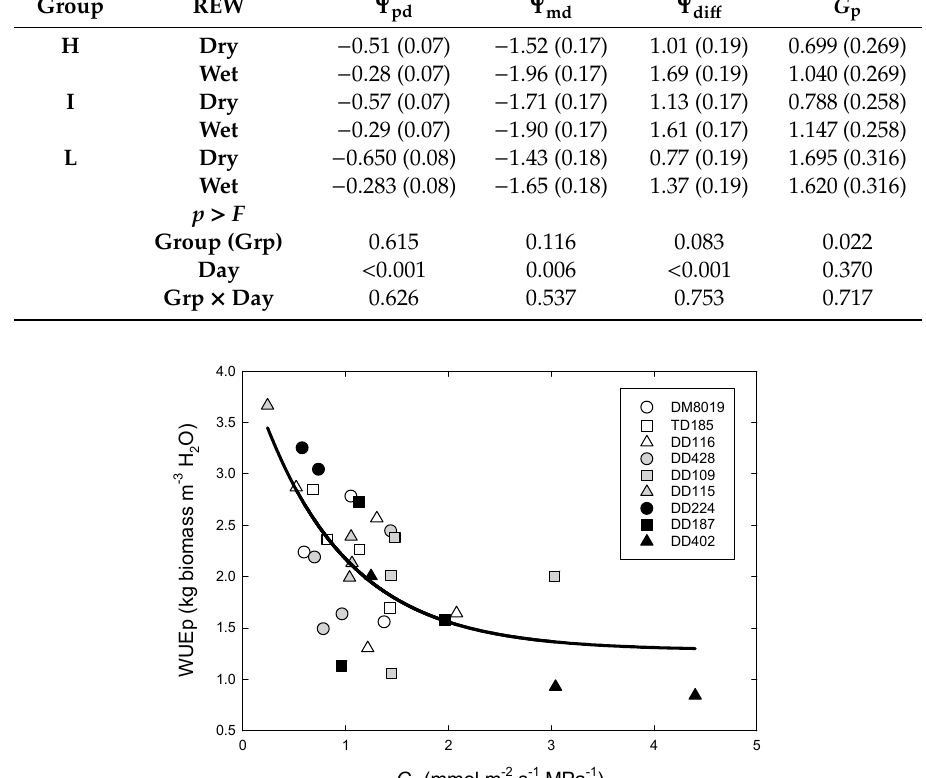
Table 3. Lsmeans (SE) and probability values for foliar and wood Δ 13 C for nine Populus clones. Genetic crosses are DD: P. deltoides × P. deltoides , DM: P. deltoides × P. maximowiczii , and TD: P. trichocarpa × P. deltoides . Cells with no shading, light shading, or dark shading represent genotypes with high (H), intermediate (I), and low (L) growth potential, respectively.